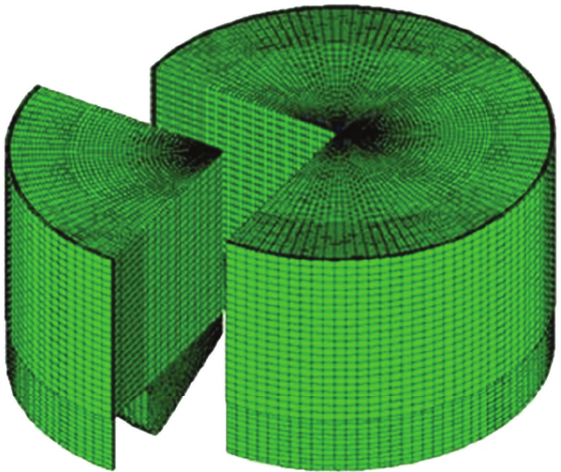
Figure 3: The full computational mesh for the Volvo D12C diesel engine, comprising 400,774 cells, and a 72-degree sector mesh with ∼ 80,000 cells at BDC.